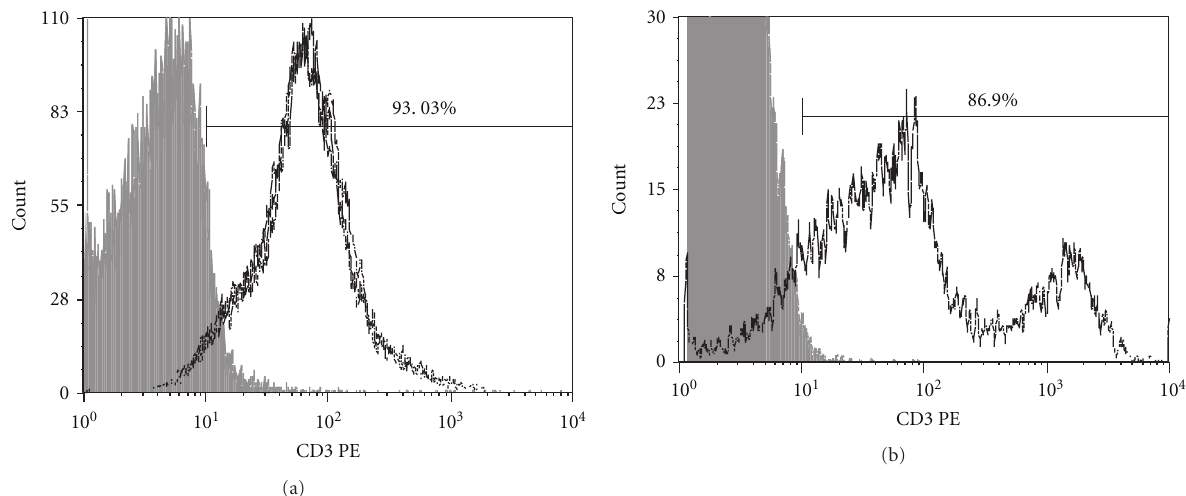
Figure 1: Fluorescent-activated cell sorting (FACS) analysis of thymocytes (approx. 93% purity) (a) and of peripheral CD3 + T lymphocytes (approx. 87%